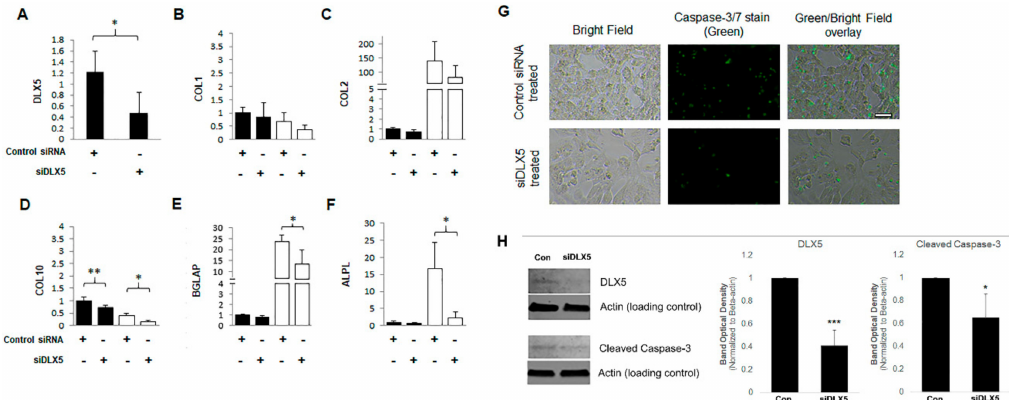
Figure 4. DLX5 knockdown results in reduced expression of hypertrophy / ossification-related genes and decreased apoptosis in BM-MSCs. Relative mRNA expression levels of ( A ) DLX5 , early chondrogenesis markers ( B ) COL1 and ( C ) COL2 , terminal hypertrophic di ff erentiation and ossification-related markers ( D ) COL10 , ( E ) BGLAP and ( F ) ALPL in DLX5 siRNA knockdown BM-MSCs vs Control-scrambled siRNA BM-MSCs. The mRNA expression results are displayed at the basal level (“Noninduced” black-colored bars in the graph) and then again after undergoing chondrogenesis (“Chondro-induced” white-colored bars in the graph) to confirm the retention of the genotype. N ≥ 3; *, p ≤ 0.05; **, p ≤ 0.01 relative to control BM-MSCs. ( G ) Caspase-3 / 7 immunofluorescent staining of DLX5 siRNA knockdown BM-MSCs vs. Control-scrambled siRNA BM-MSCs. Scale = 250 µ m. ( H ) Western blot analysis of